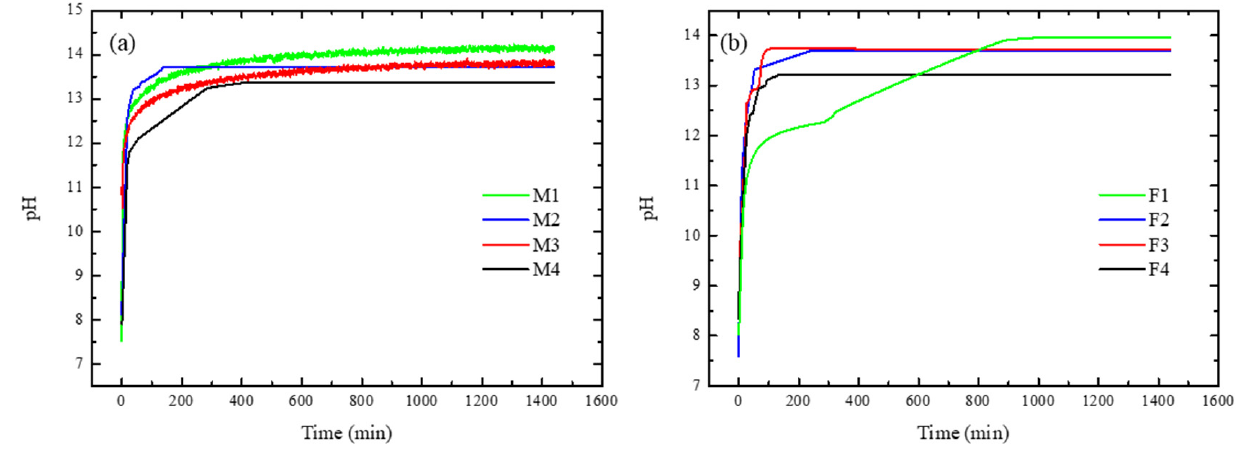
Figure 12. Hydroxide ions exchange rate for membranes containing: ( a ) PEI and ( b ) Fumion ® .